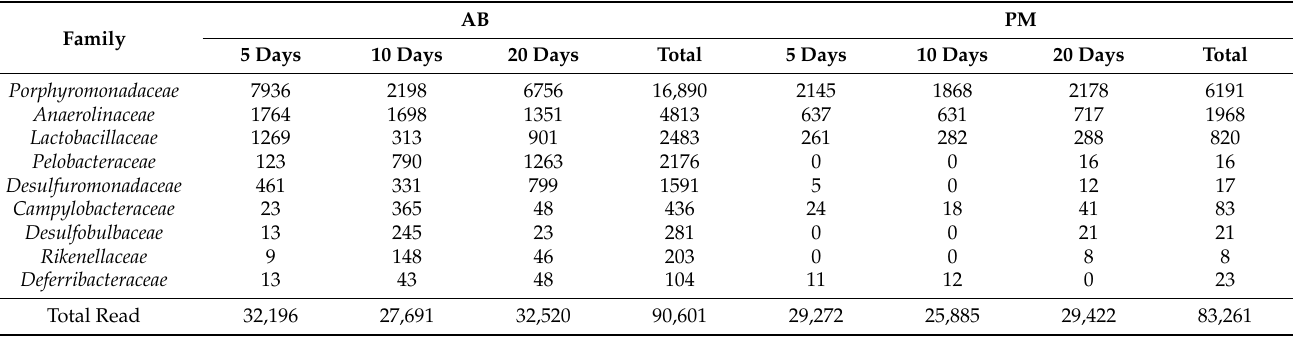
Table 1. Read numbers for bacterial families that were more abundantly detected in the AB fractions than those in the PM